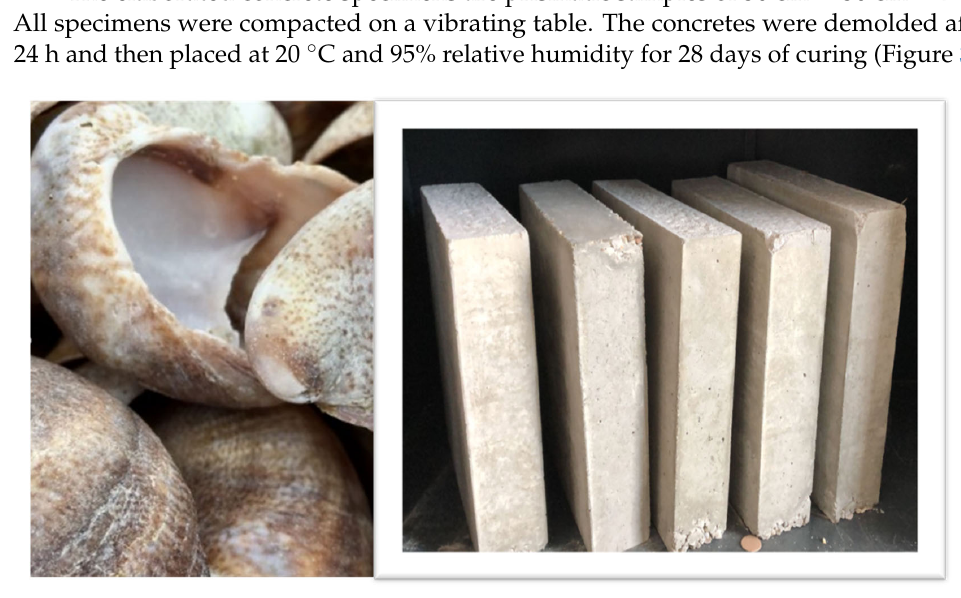
Table 2. Composition of the different mortar and concrete mixes (Kg.m − 3 ). Mortar